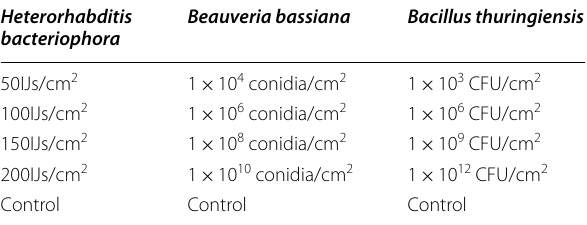
Table 2 Tested biocontrol pathogens and the concentrations applied against 3rd instar larvae of Spodoptera litura under greenhouse conditions